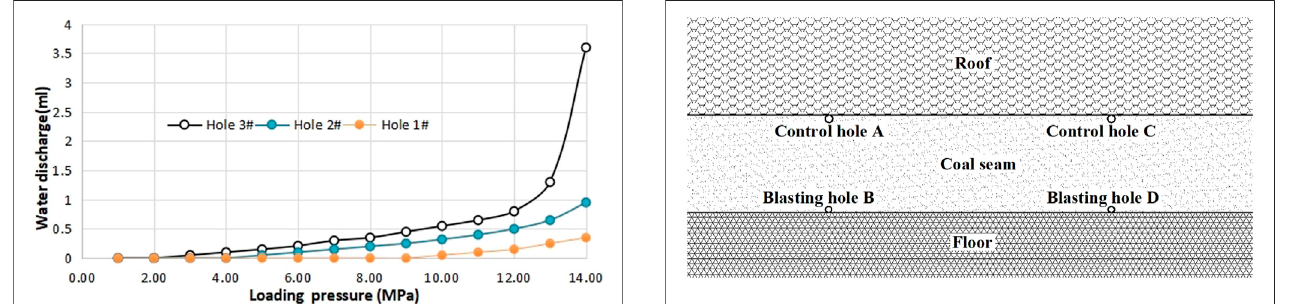
FIGURE 6 | Relationship between loading pressure and deformation of boreholes near the fl oor.